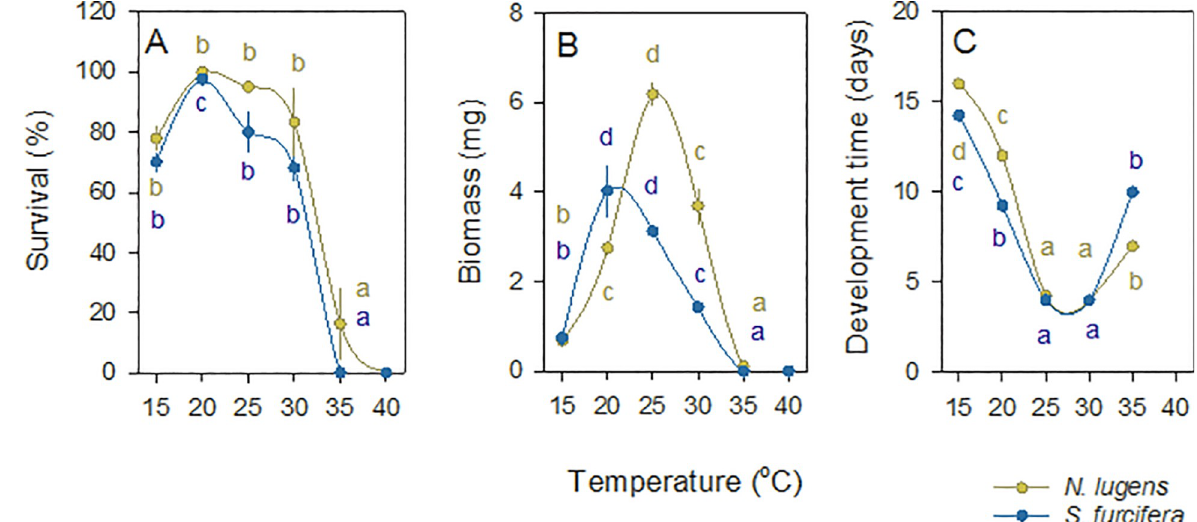
Fig 6. Effects of temperature on the survival and development of planthopper nymphs. BPH (brown symbols and lines) and WBPH (blue symbols and lines) nymphs were reared on IR22 at temperatures ranging from 15˚C to 40˚C. Temperature effects on (A) nymph survival, and (B) the maximum biomass of surviving nymphs, as well as (C) the time for 50% of nymphs to develop to third instars are indicated. Numbers are based on accumulated data over 15 days of the experiment. Bars indicate standard errors (N = 4). Lowercase letters indicate homogenous temperature groups (Tukey, P > 0.05) based on univariate (A and B) and multivariate (C)